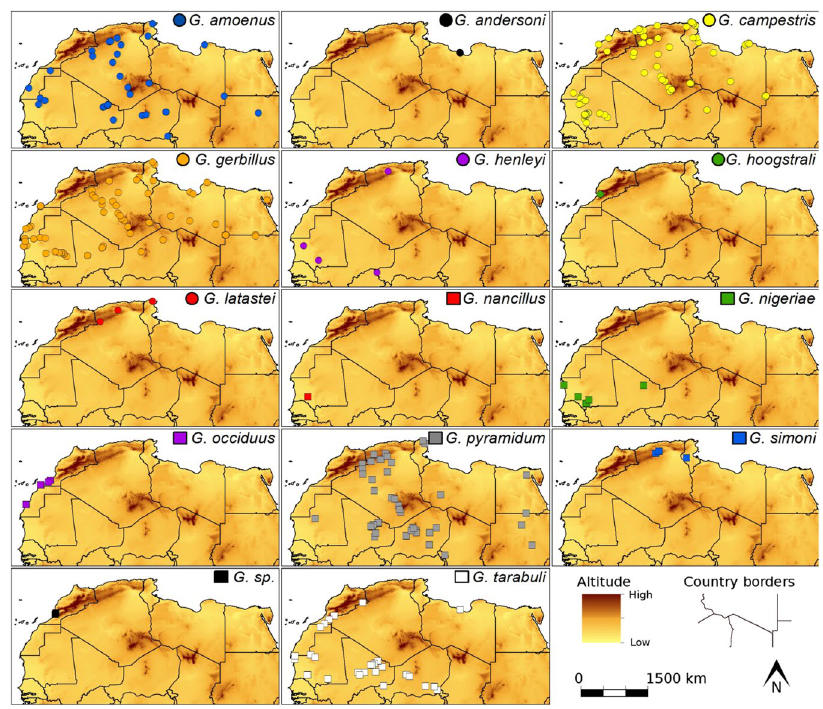
Figure 1. Maps of distribution of specimens included in this study (generated in: ArcGIS ver. 10.1, www.arcgis. com; see detailed information in Supplementary Material: Data